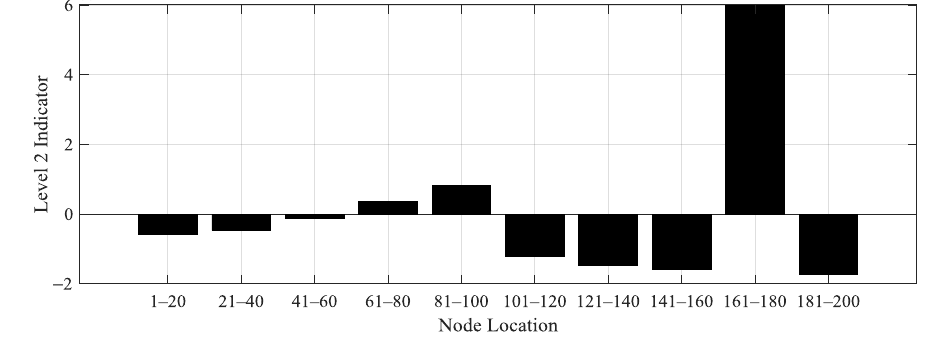
Figure 21. Level 2 damage indicator for Case 2.